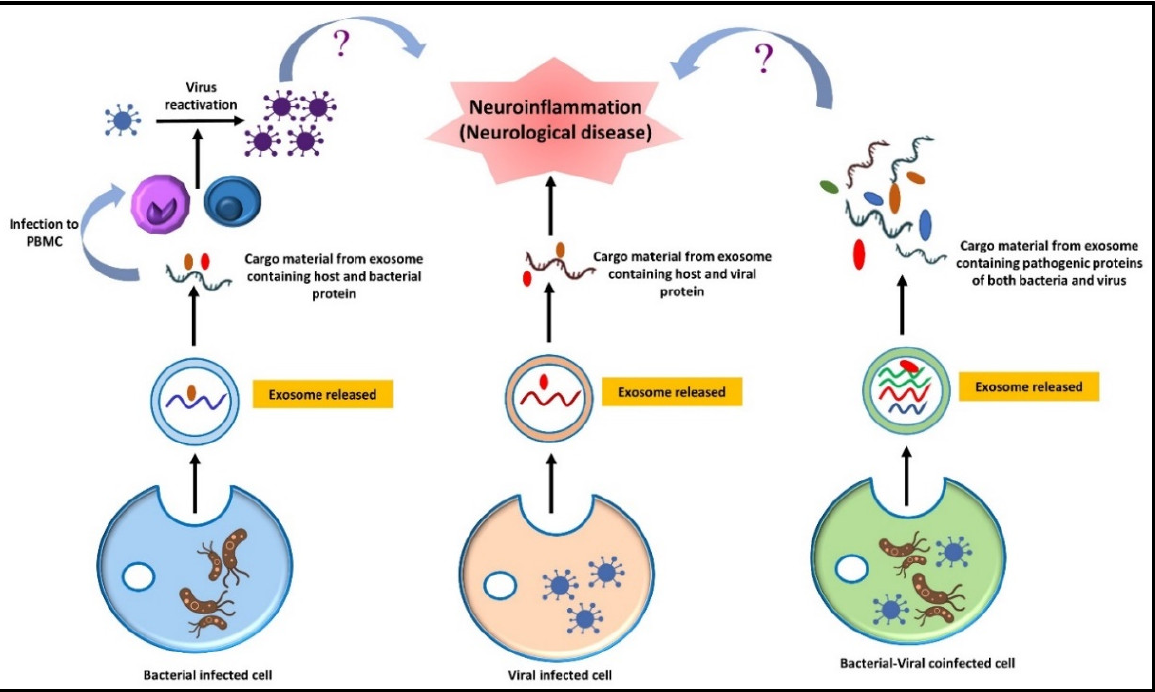
Figure 6. Schematic diagram depicting the effect of a lone bacterial or viral infection and pathogenic coinfection in engendering neuroinflammation. The role of extracellular vesicles from bacteria- infected cells in virus reactivation via PBMC in contributing to neuroinflammation has to be explored. Meanwhile, the analysis of the combined effect of pathogens on various neurodegenerative markers and inflammation could be contemplated in the co-infection models. NB:? signifies the nonavailability of direct evidence and study needs to be done in this aspect.